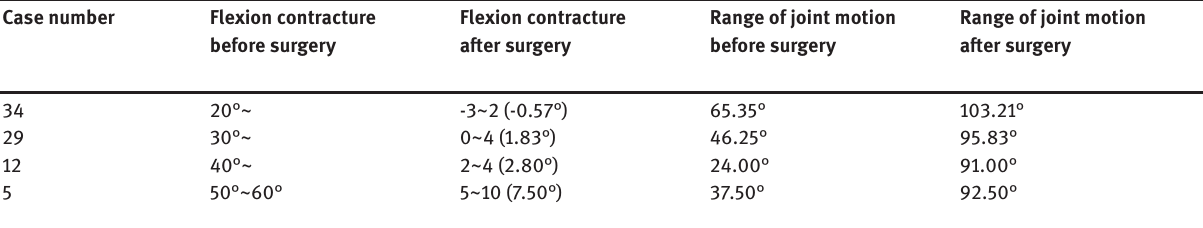
Table 2: Improvement situation of flexion contracture and range of joint motion between patients before and after surgery. Case number Flexion contracture Flexion contracture Range of joint motion Range of joint motion before surgery after surgery before surgery after